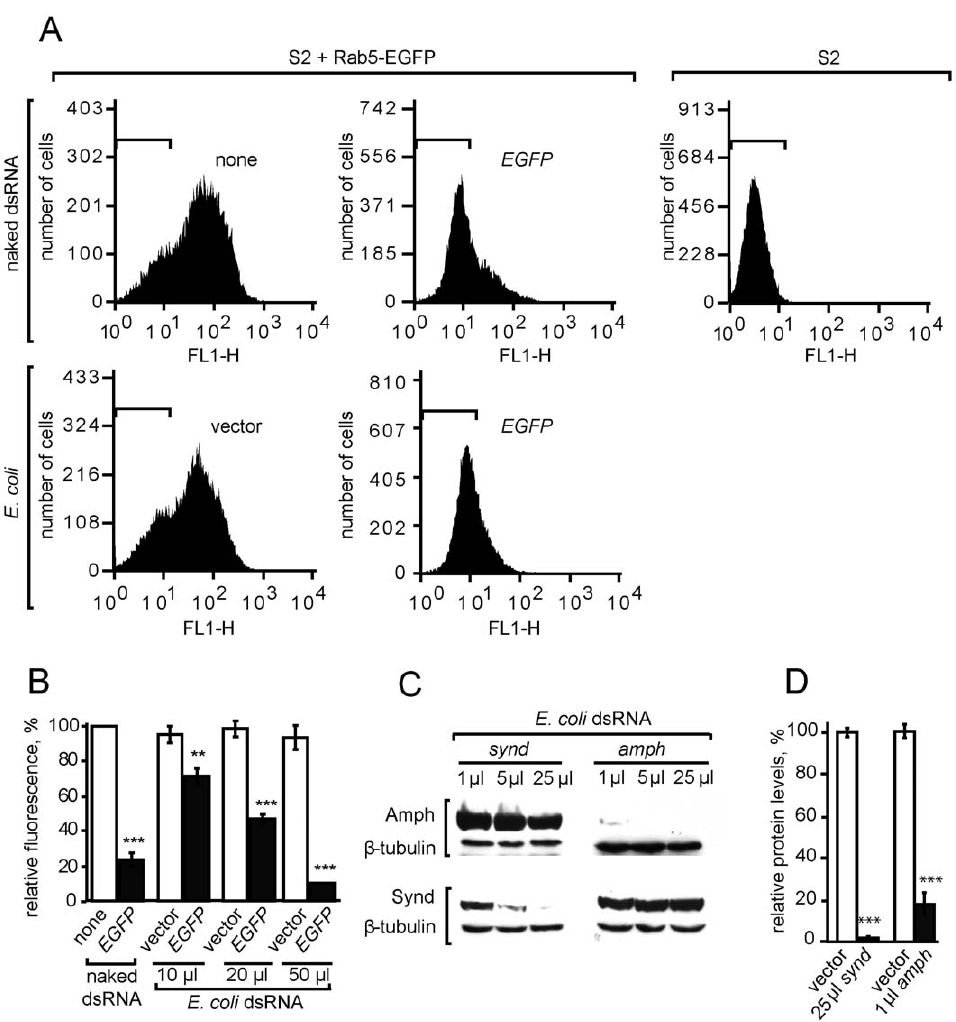
Figure 2. Efficiency and specificity of RNAi induced by dsRNA-expressing E.coli . ( A ) Fluorescence loss in Rab5-EGFP-expressing S2 stable cell line due to RNAi induced either by 1 m g of naked EGFP dsRNA or by 50 m l of EGFP dsRNA-expressing E.coli . Representative FACS histograms are showing numbers of S2 cells with different fluorescence intensities. Horizontal bars in each graph (approximately 100 to 101) show the fluorescence range of wild-type S2 cells (as in the top right histogram). ( B ) Quantification of EGFP fluorescence levels in Rab5-EGFP-expressing S2 cells, treated with either 1 m g of EGFP dsRNA or varying quantities of E. coli (OD600=1.2) that express EGFP dsRNA. The graph shows the level of EGFP fluorescence, normalized to cells treated with no RNAi. ( C ) Western blots of amphiphysin, syndapin or b -tubulin in lysates from S2 cells treated for 72 hours with E. coli that express amph or synd dsRNA. ( D ) Bar graph shows levels of amphiphysin and syndapin relative to b -tubulin. Knockdown was quantified in S2 cells treated with E. coli that expressed synd (25 m l) or amph (1 m l) dsRNA; amphiphysin was undetectable after treatment with larger amounts of E. coli . Values are averages of three independent experiments. Error bars indicate standard error of the mean. ** P , 0.01; *** P , 0.005; two-tailed